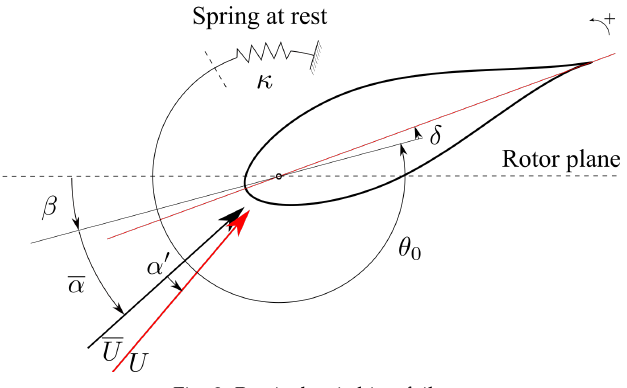
Fig. 2: Passively pitching foil.